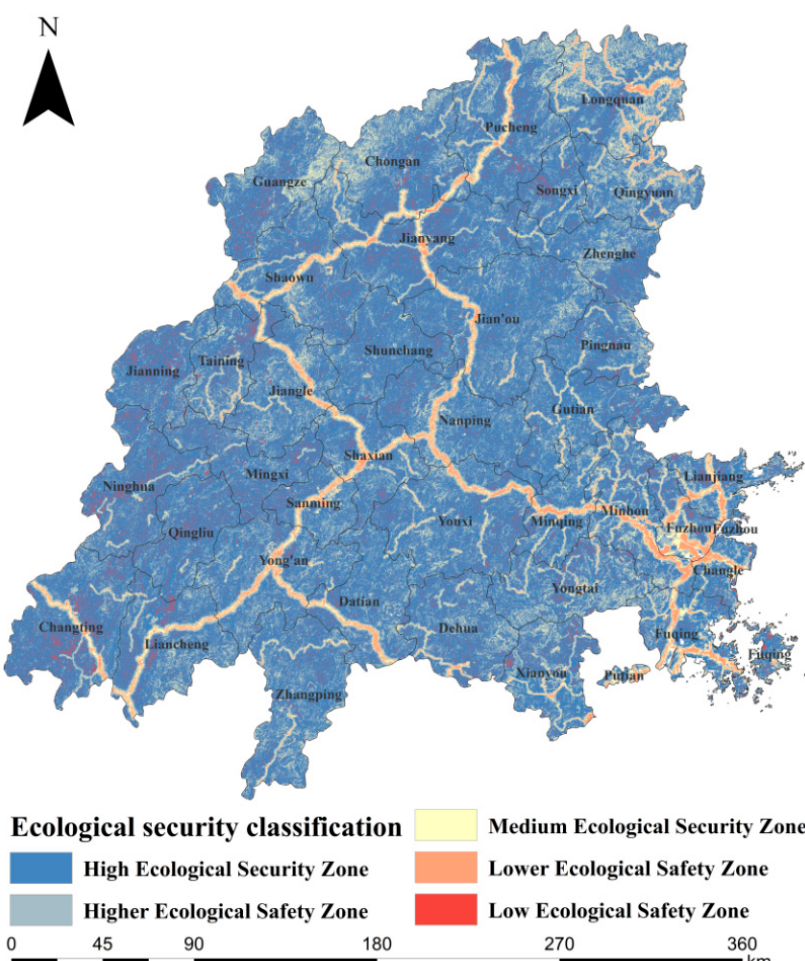
Figure 5. Ecological security classification of the Minjiang River Basin. Table 7. Area statistics of Ecological Safety Zone classification.